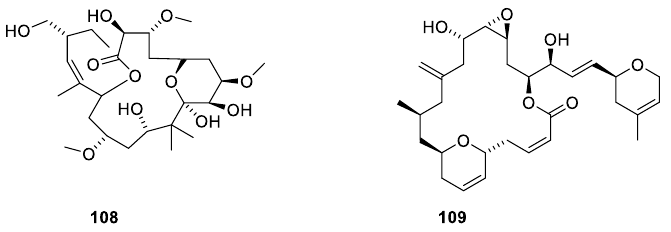
Figure 29. Microtubule-stabilizing agents peluroside A ( 108 ), laulimalide ( 109 ).